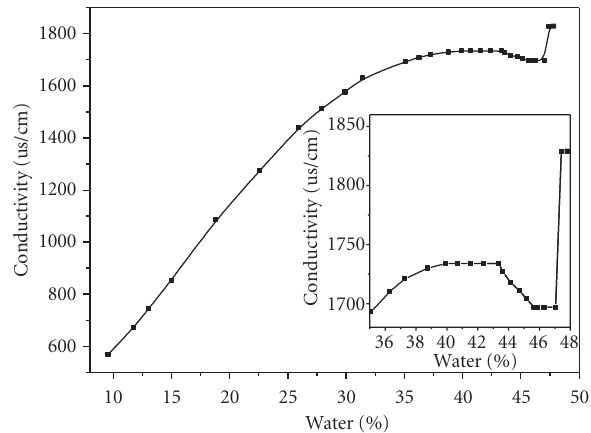
Figure 1: Relationship between the electrical conductivity and the water concentration with the weight ratio of n-hexanol to CTAB is